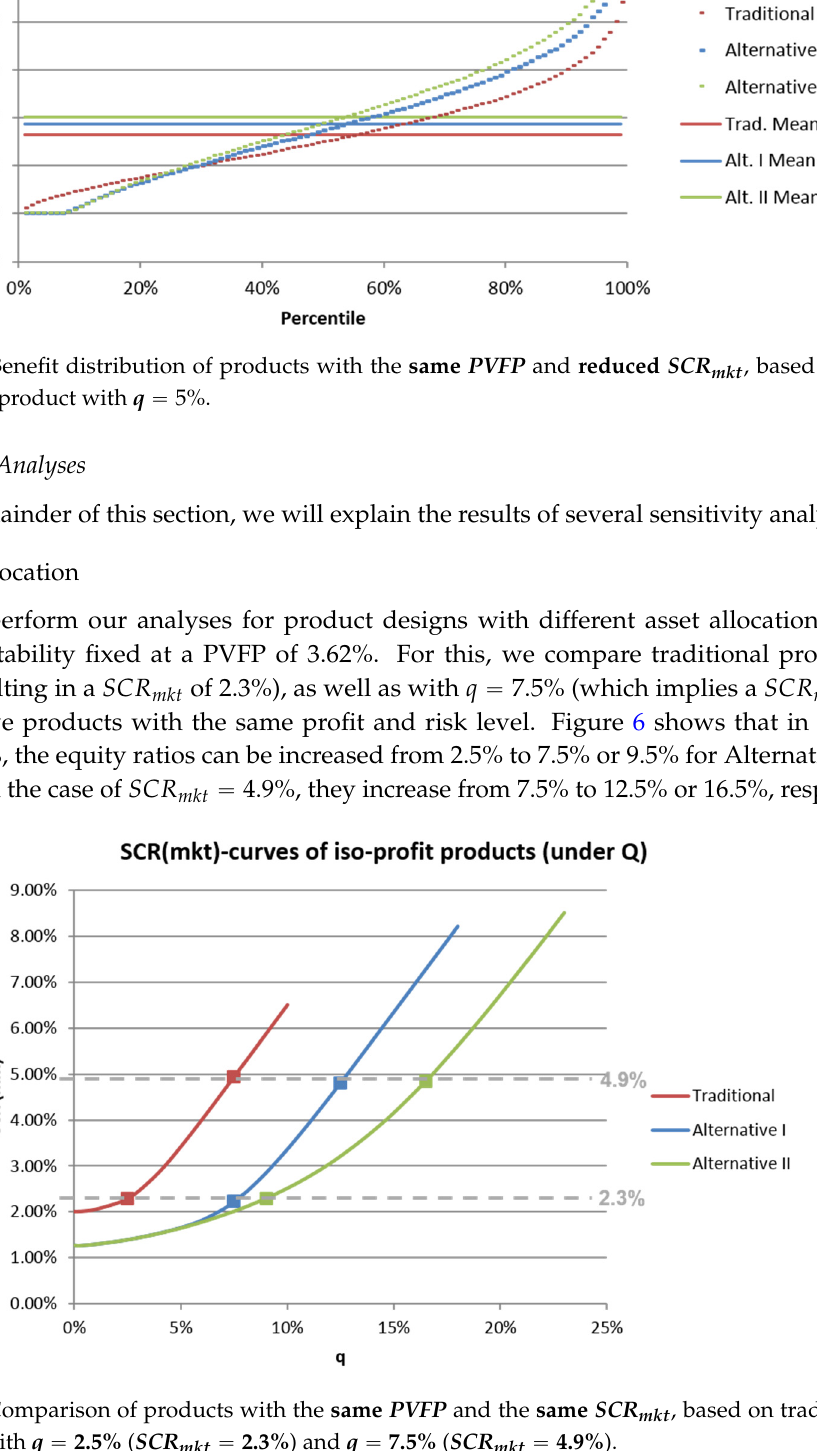
perspective. We can see that these products, which leave the insurer’s profitability unchanged and